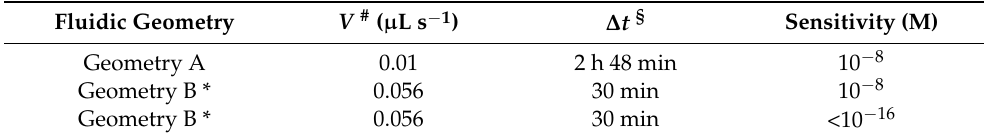
Table 3. Comparison of optimized parameters depending on the different geometries of the fluidic channel for on-chip magnetic hyperthermia and fluorometric